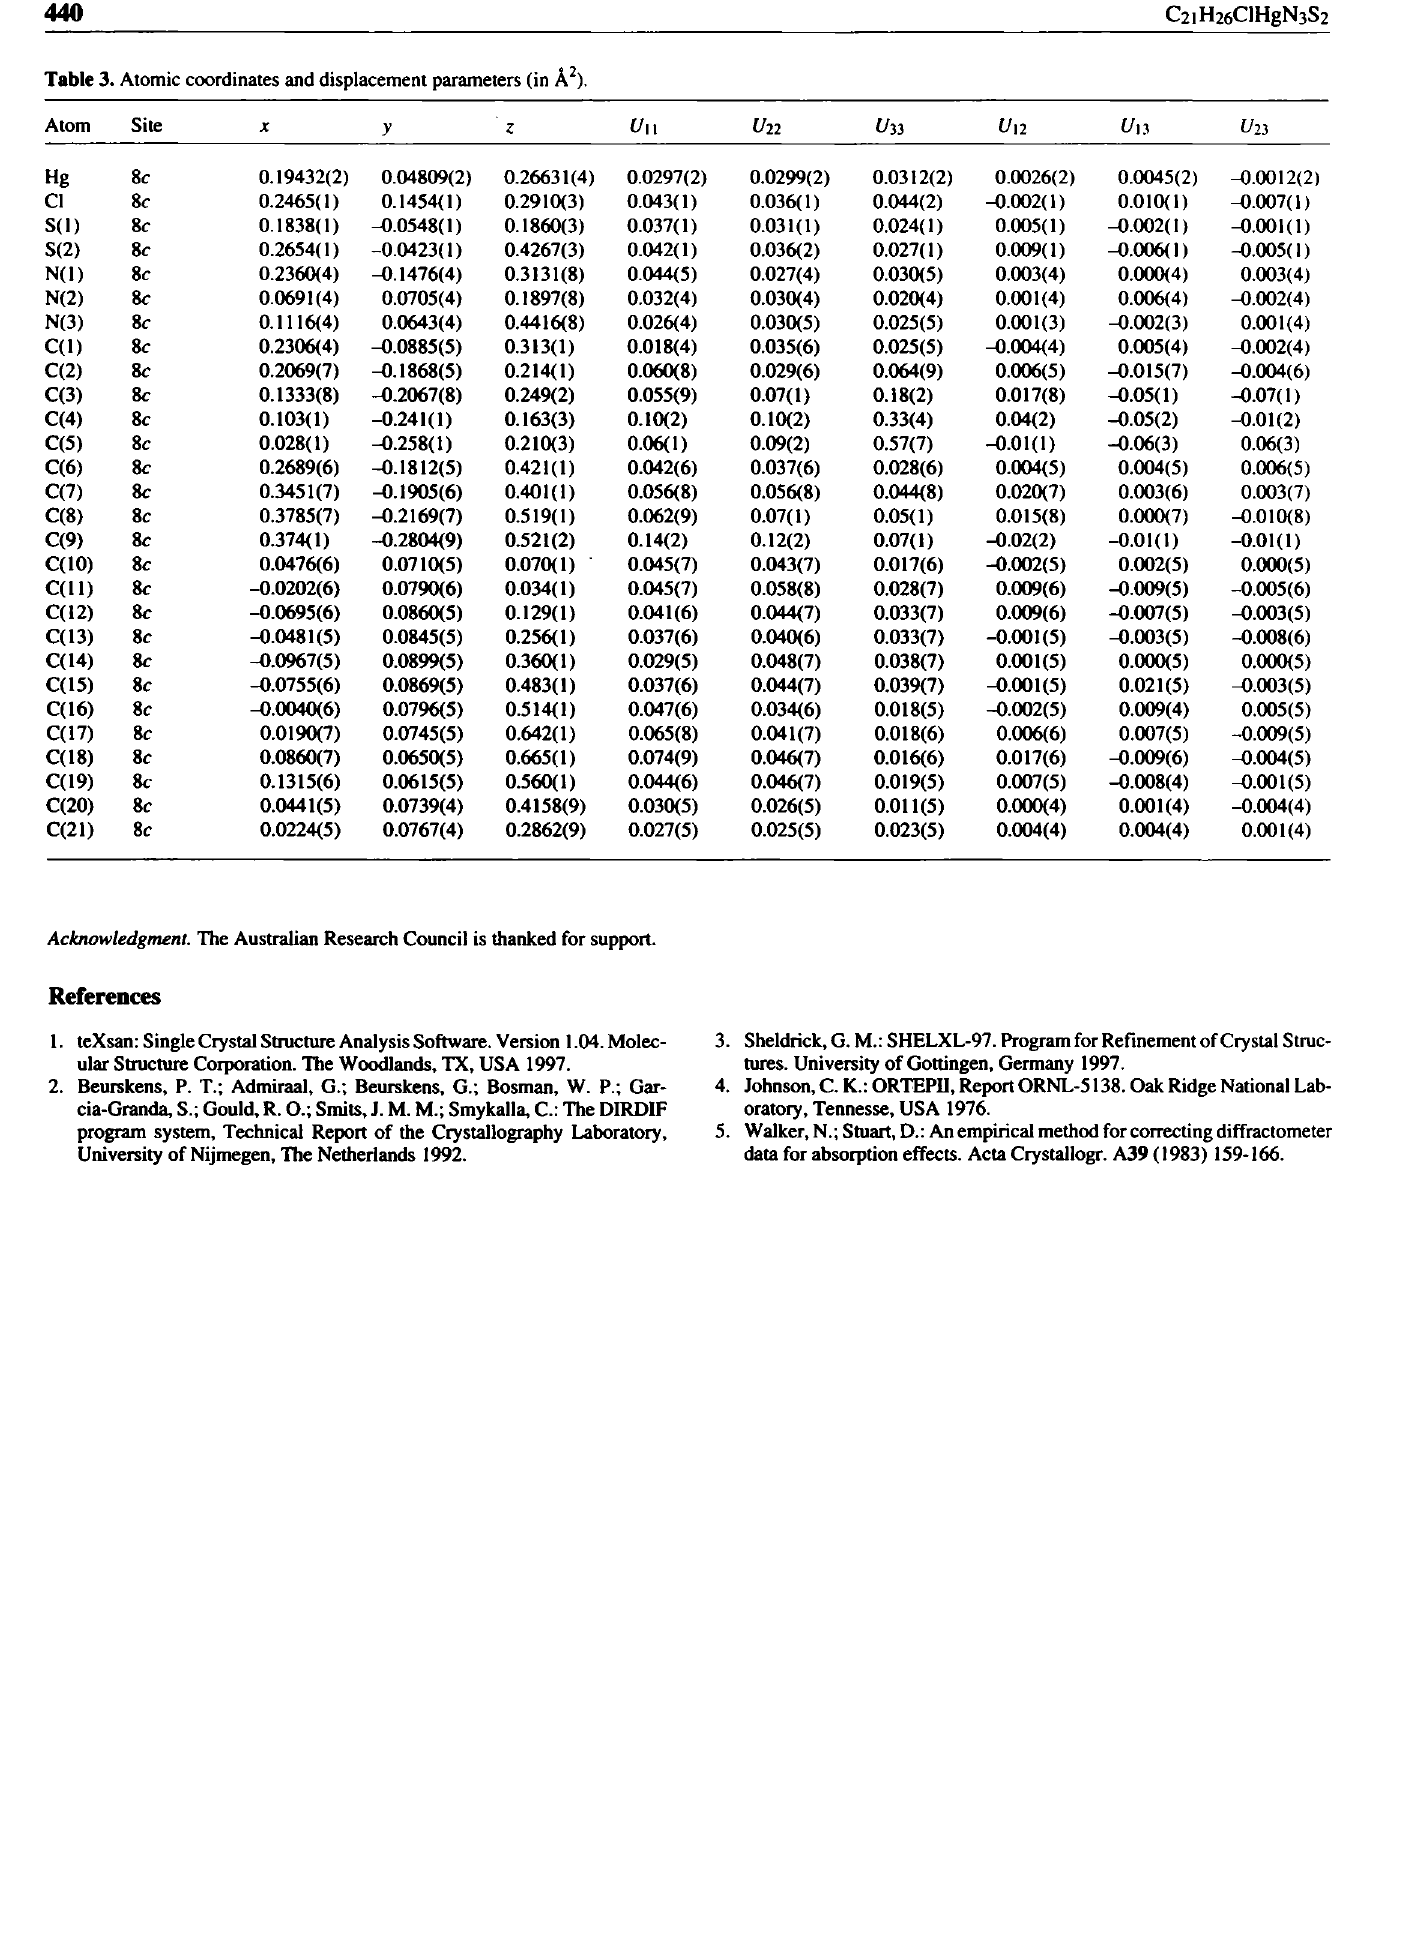
Table 3. Atomic coordinates and displacement parameters (in Ä 2